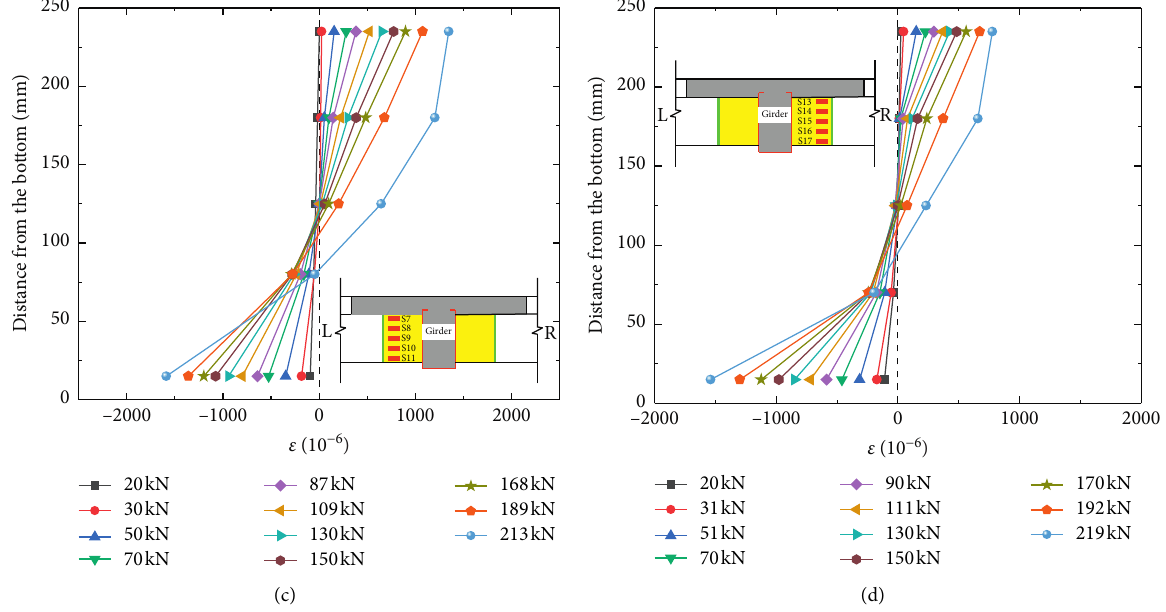
Figure 17: Strain distributions of GBJ2. (a) Beam section-L. (b) Beam section-R. (c) Shaped sleeve section-L. (d) Shaped sleeve